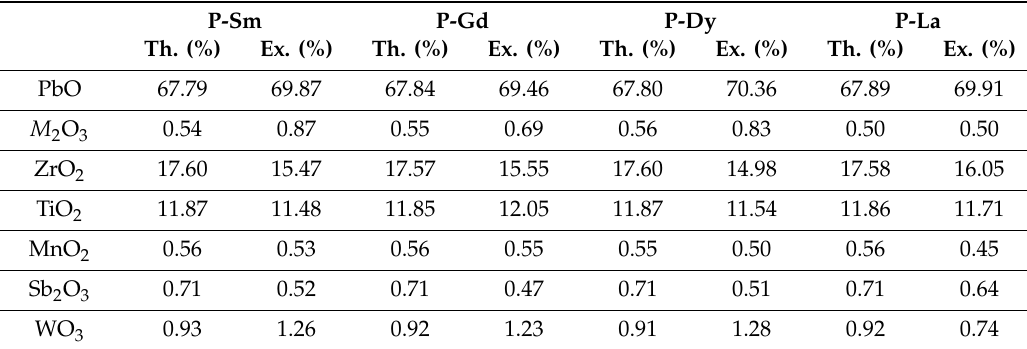
Table 2. Theoretical and experimental percentages of elements of PZT-type ceramics.